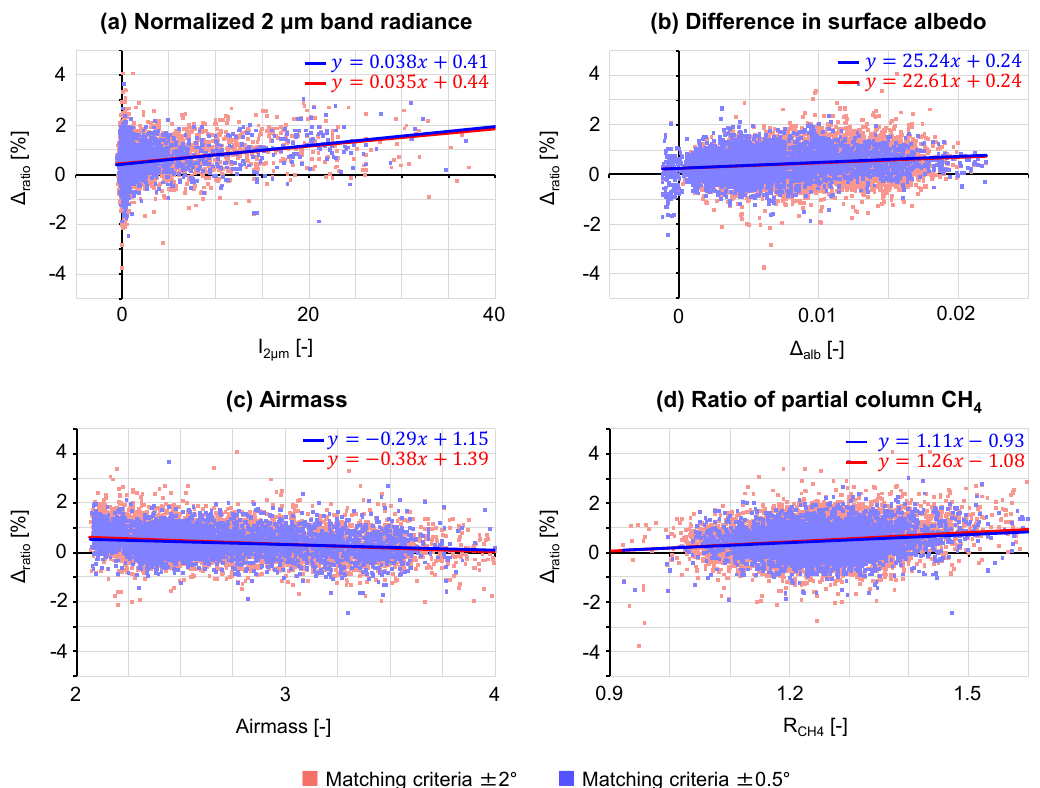
Figure A2. Relationship between the relative difference in the ratio component between GOSAT and TCCON ( Δ ratio ) and the related variable: ( a ) normalized 2 μ m band radiance (I 2 μ m ); ( b ) difference in retrieved surface albedo (CH 4 band minus CO 2 band, Δ alb ); ( c ) airmass; ( d ) ratio between the partial column-averaged dry-air mole fractions for the lower atmosphere and that for the upper atmosphere (R CH4 ). Results for the different matching criteria are plotted (GOSAT data within ±2 ° and ±0.5 ° latitude/longitude boxes centered at each TCCON site). Linear regressions are depicted by solid lines. For I 2 μ m and R CH4 , the data with cloud fraction = 0 were used. For Δ alb and airmass, the data with cloud fraction = 0 and I 2 μ m ≤ 1 were used.